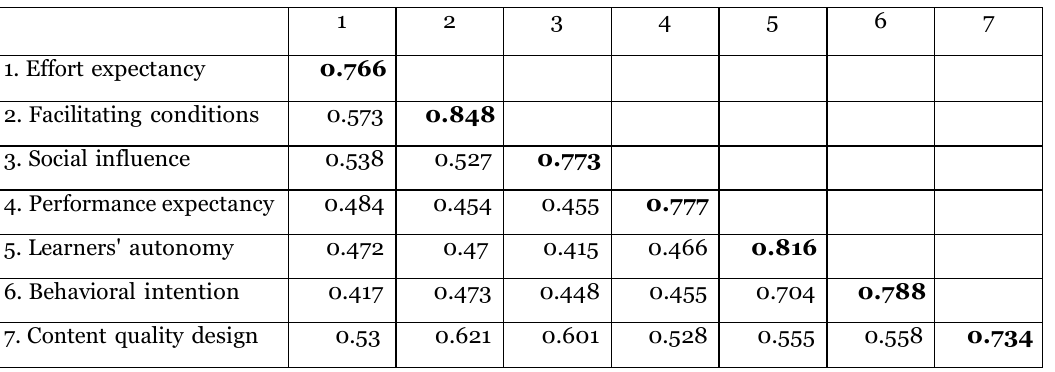
Discriminant Validity of Measurement Model